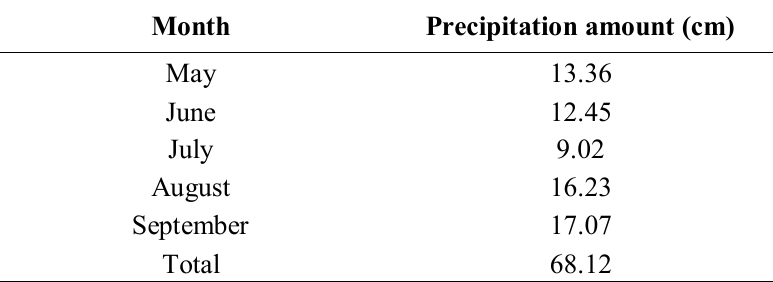
Table 2. Precipitation recorded from May to September in